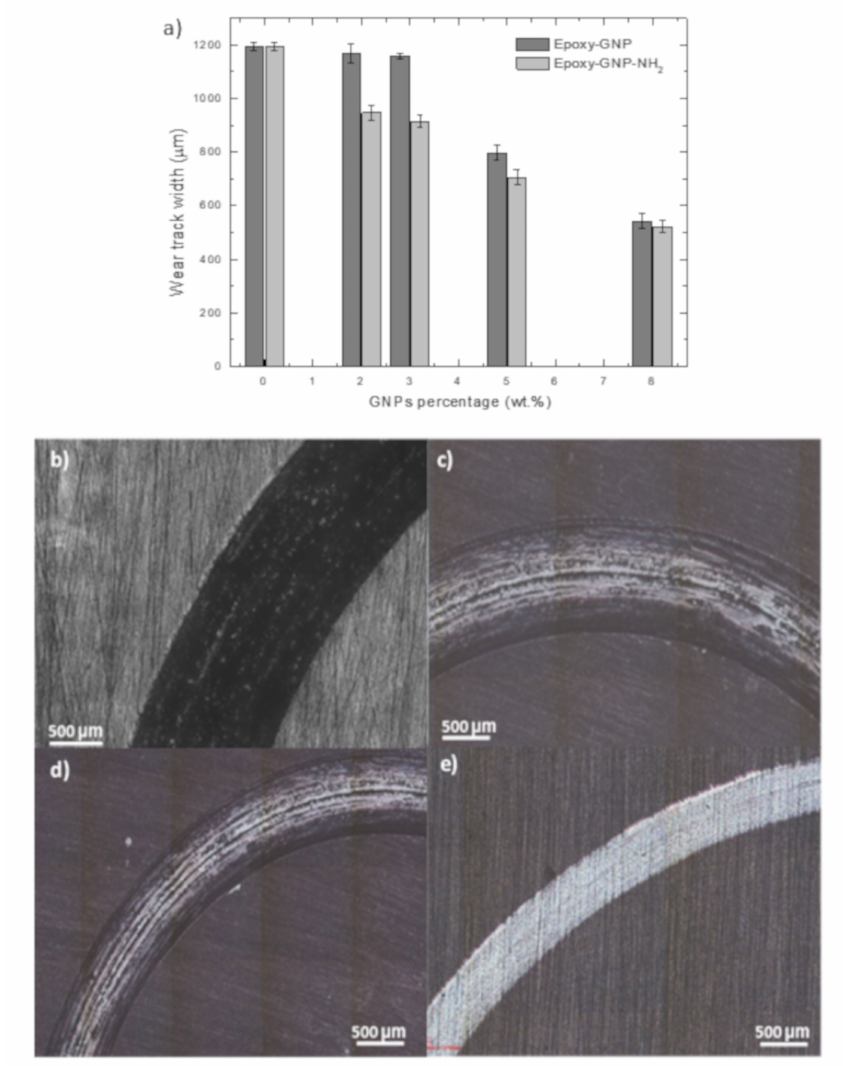
Figure 5. Wear track width ( a ) and 2D Profilometer images of wear track of neat epoxy ( b ), and epoxy with 3 wt.% non-functionalised GNPs ( c ), 3 wt.% amino-functionalised GNPs ( d ) and 8 wt.% amino-functionalised GNPs ( e